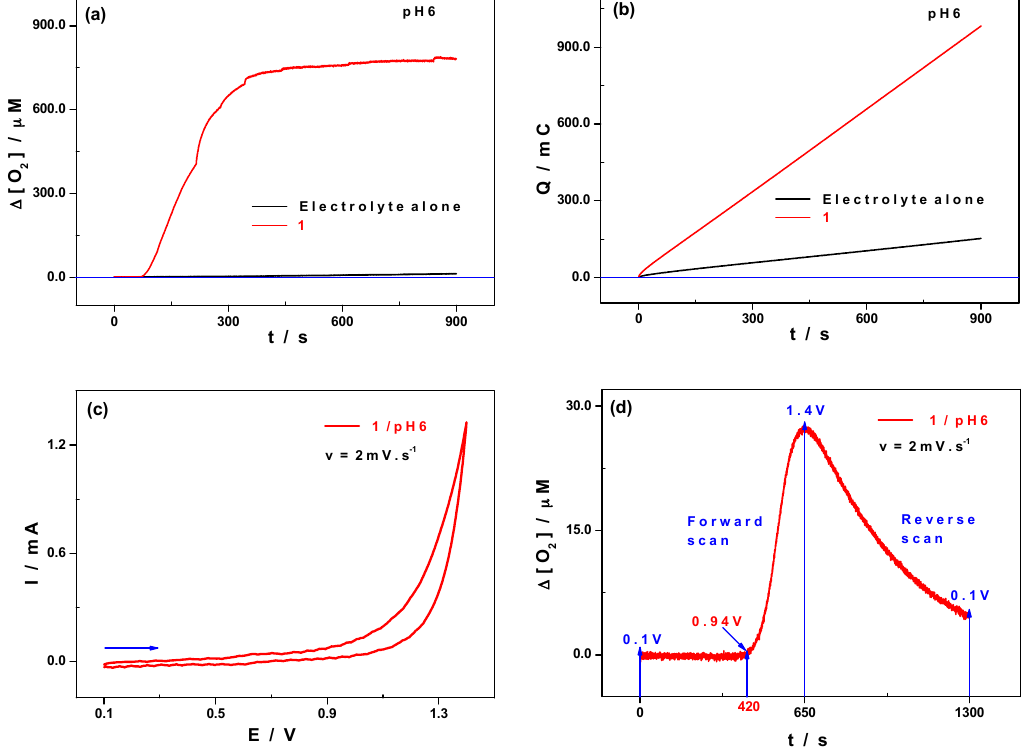
Figure 8. Electrolysis on a glassy carbon plate ca. 1 cm 2 in 1.0 M CH 3 COOLi + CH 3 COOH/pH 6; E = 1.4 V vs. SCE; t = 900 s. ( a ) Evolution of the dioxygen concentration as a function of time in the absence (black) and in the presence (red) of 1 ; ( b ) Charge consumed as a function of time; ( c ) CV of 1 in the same medium at a scan rate of 2 mV · s − 1 ; potentials were initially scanned from +0.10 V to +1.40 V (Mn 2+/4+ oxidation followed by Mn 4+/5+ and H 2 O electro-catalytic oxidation), then back to +0.1 V; ( d ) Variation of the concentration of dioxygen in the medium of study, [O 2 ], as a function of the electrode potential scan (directly related with time). Polyoxometalate concentration: 0.5 mM; working electrode: glassy carbon plate ca. 1 cm 2 ; reference electrode: SCE; auxiliary electrode,